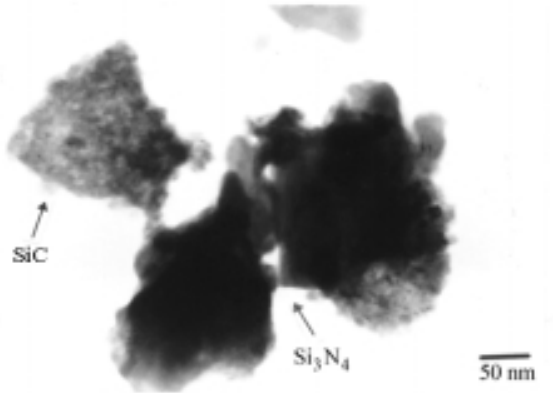
Figure 2. TEM micrograph of the Si 3 N 4 /SiC nanocomposite